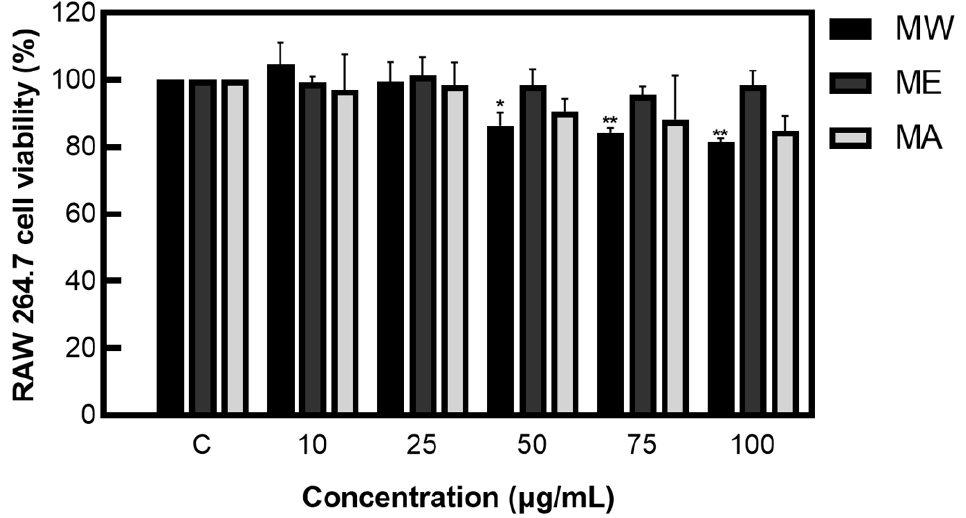
Figure 1. Cell viability of M. pruriens extracts on macrophage cell (RAW 264.7). MW: M. pruriens extracted with hot water; ME: M. pruriens extracted with 70% ethanol; MA: M. pruriens extracted with 70% acetone. Result are means ± SD of triplicate data (significantly different according to the Tukey test and significant compared to the control. * p < 0.05, ** p < 0.01).